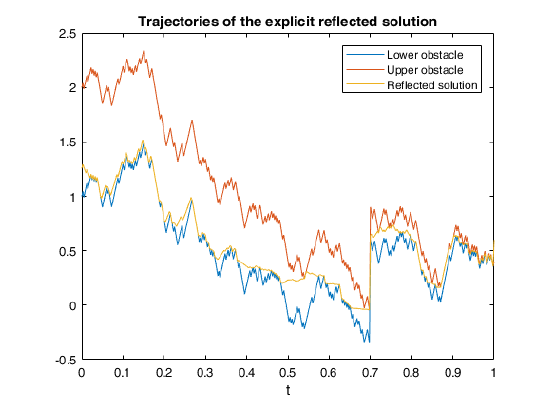
Figure 4. One path of ˜ y n in the explicit reflected scheme ( τ = 0.7).